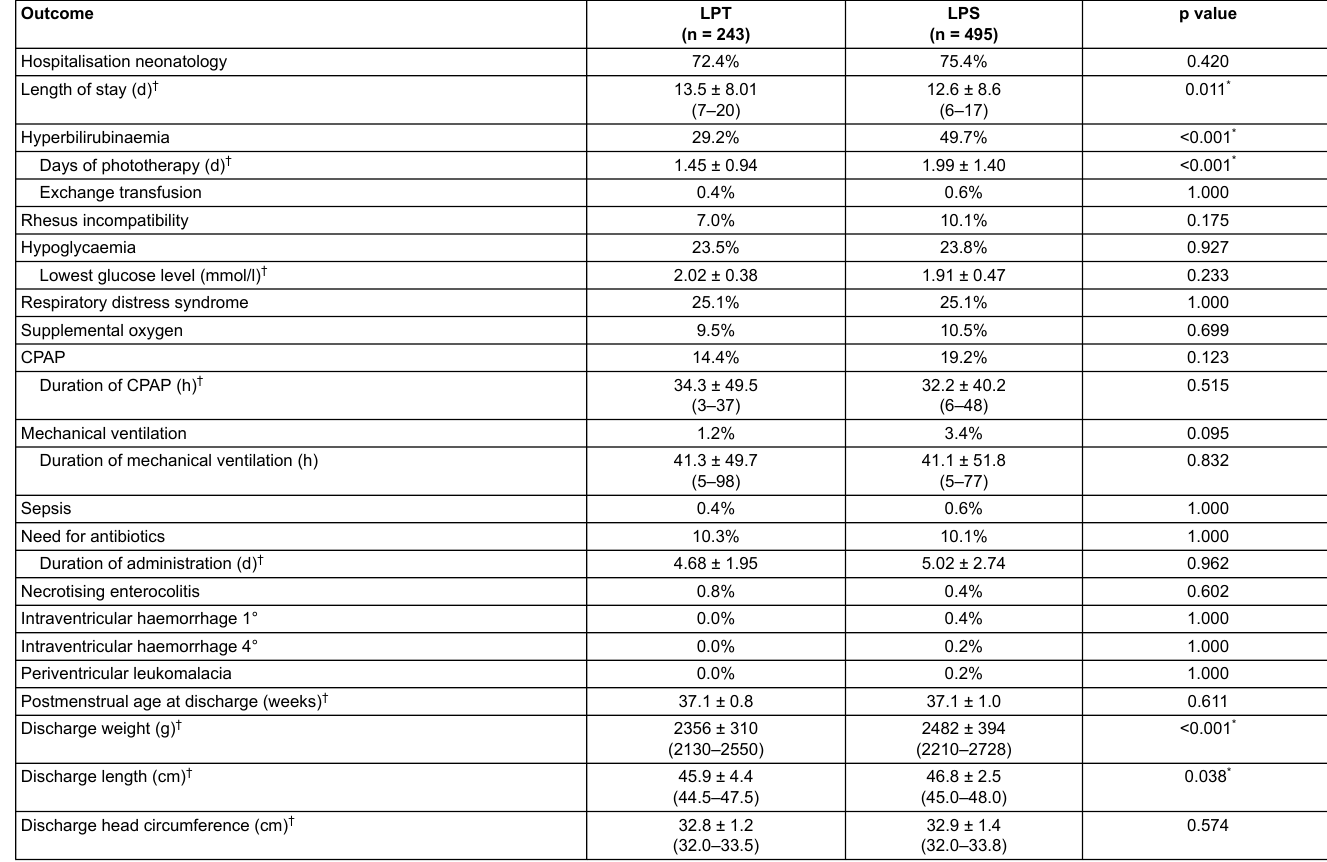
Table 4: Neonatal outcomes of late preterm twins compared with late preterm singletons.